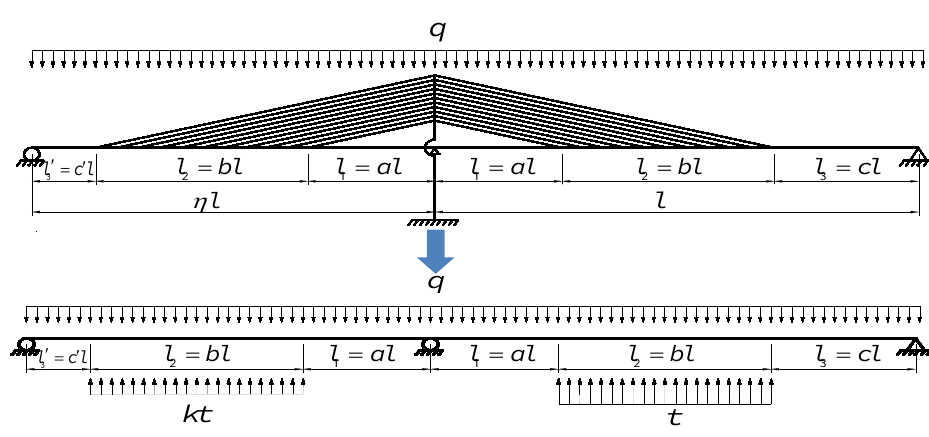
Figure 3. Simplified mechanical model.